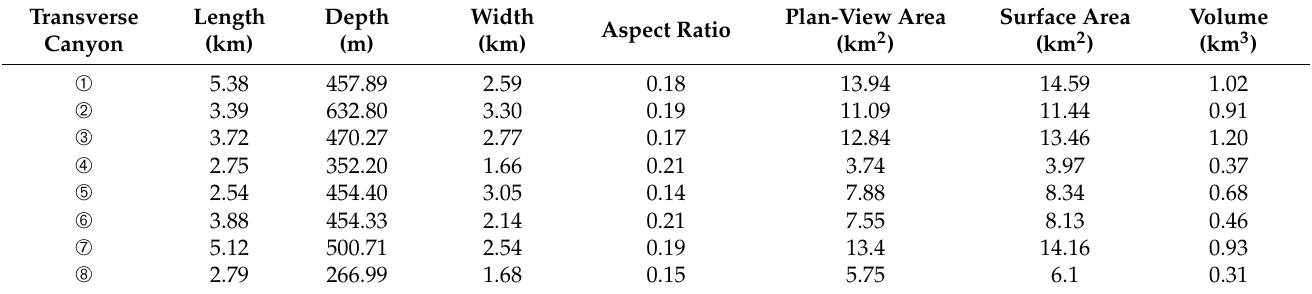
Table 1. The values of the spatial attributes-surface area and volume-of each transverse canyon. Transverse